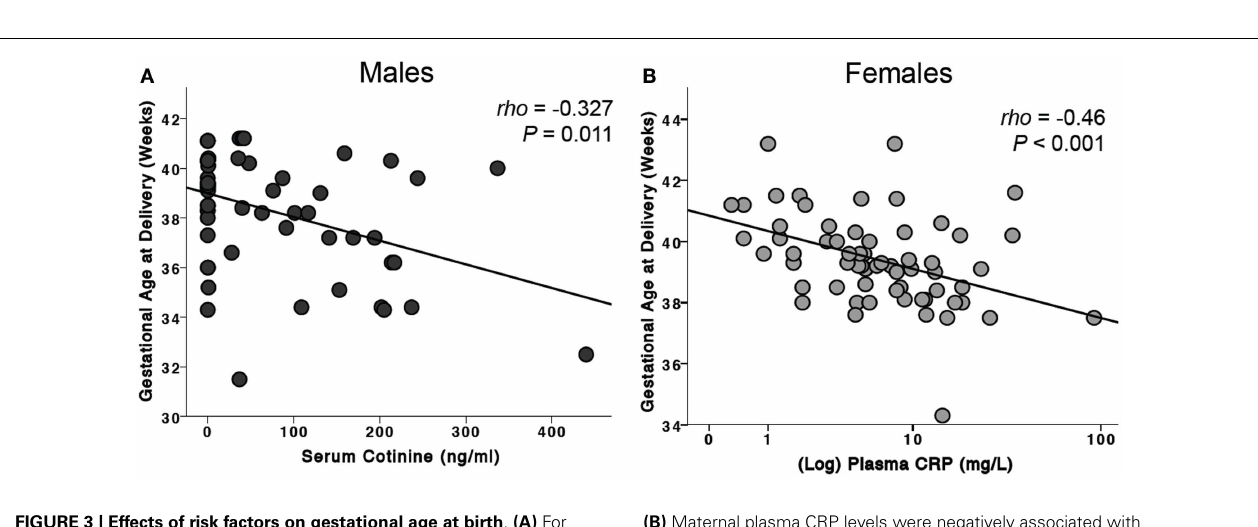
FIGURE 3 | Effects of risk factors on gestational age at birth . (A) For male infants, serum cotinine was negatively associated with gestational age at delivery.This association was not seen in female infants.